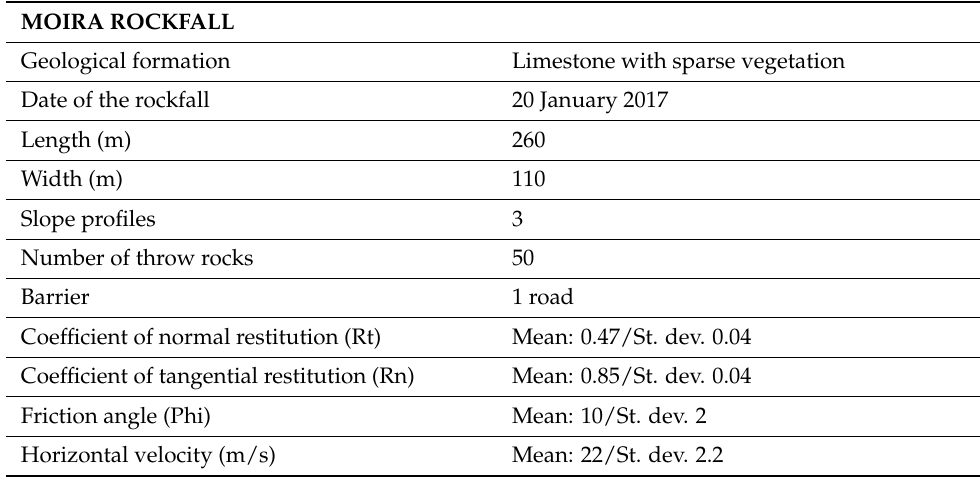
Table 2. Geological and material